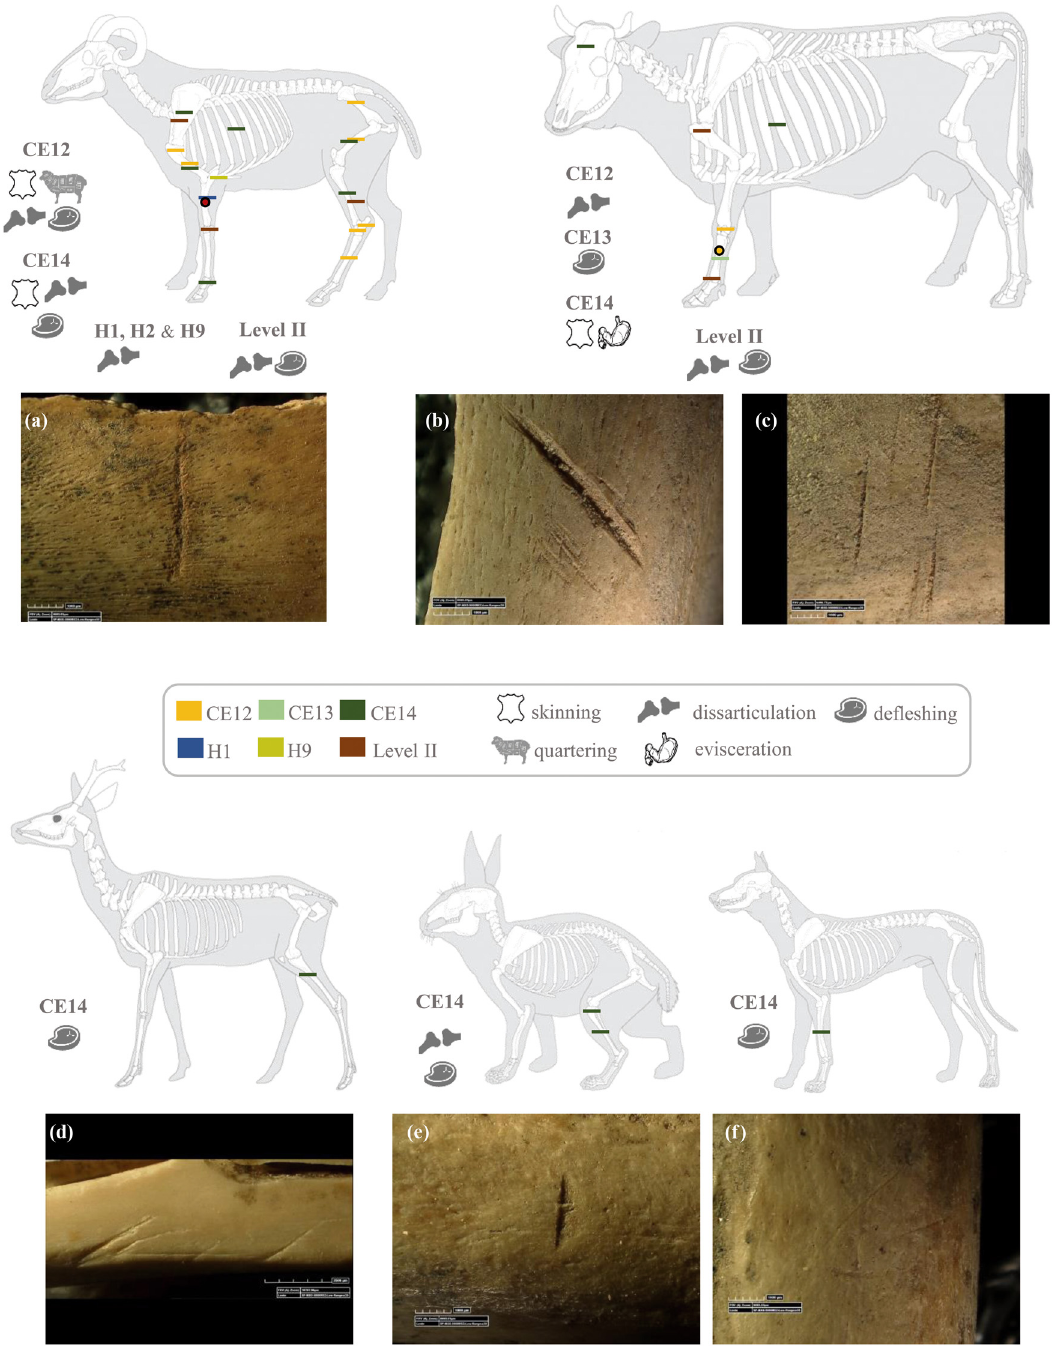
Figure 7: Location of cut marks ( line ) and percussion marks ( circle ) by anatomical element and taxon. Detail photographs ( Hirox KH8700 digital microscope ) of some of these cut marks, all of them indicating the de fl eshing of the animals: ( a ) incision in scapula of domestic caprine ( CE14 ) , ( b and c ) incisions in cattle metacarpus ( CE13 ) , ( d ) incisions in rabbit tibia ( CE14 ) , and ( e and f ) incisions in dog radius ( CE14 )